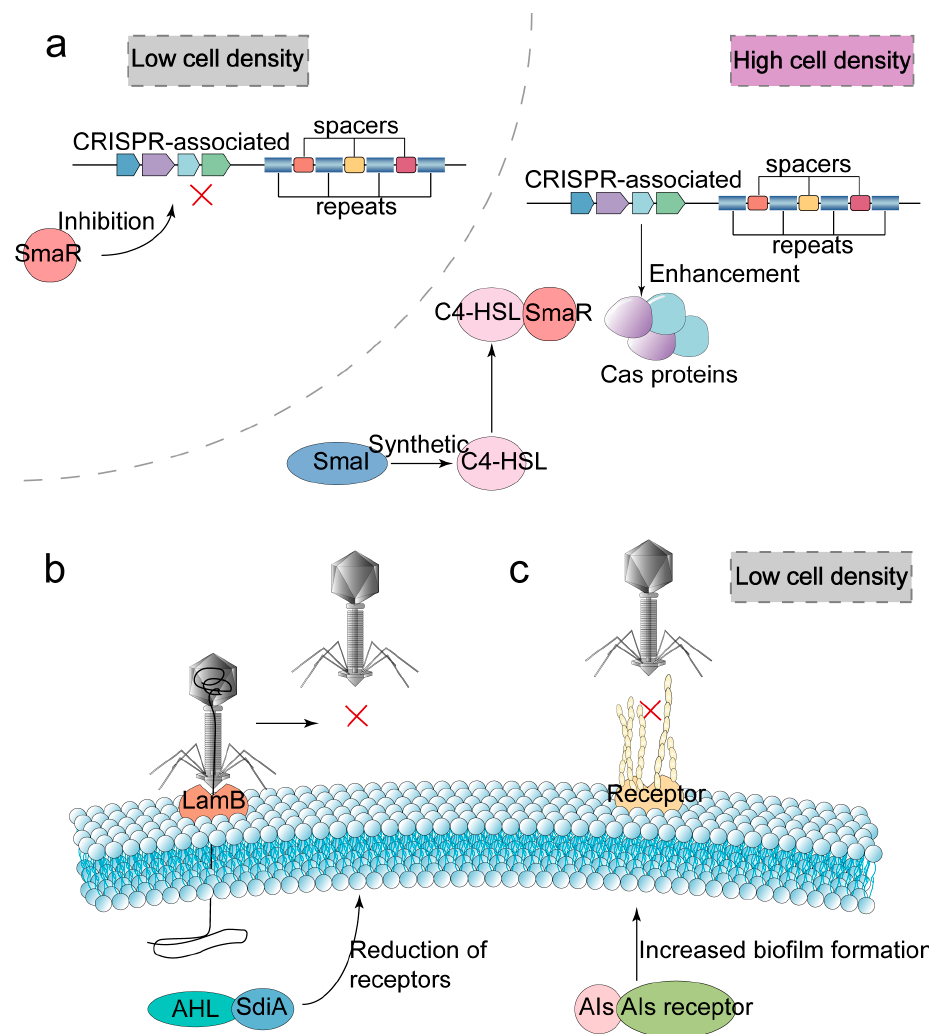
Figure 6. The QS system of bacteria resists phage infection by synergizing the CRISPR-Cas system or hindering phage adsorption. The QS system consists of QS signaling synthases, extracellular signaling molecules called autoinducers (AIs), and QS receptors. ( a ) Under conditions of high population density, the N -butanoyl- L -homoserine lactone (C4-HSL) produced by the smaI/smaR-type QS system binds to smaR, hinders the repressive effect of the DNA-binding repressor smaR on cas genes and promotes the expression of cas genes. ( b ) The binding of the QS signaling molecule acyl-homoserine lactones (AHL) to its receptor SdiA can reduce the number of λ phage receptors LamB (the symbol red cross in the figure indicates that the phage‘s adsorption is inhibited). ( c ) Under the condition of low cell density, the QS system can increase biofilm production to mask phage receptors and hinder phage adsorption.